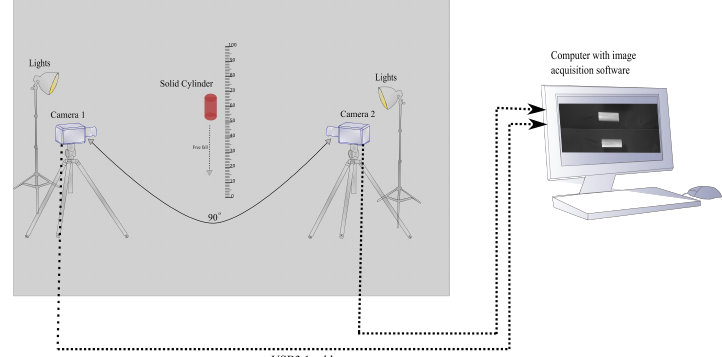
Figure 1. Measurement setup with two high-speed cameras placed 90 degrees apart and pointing to a free-falling solid cylinder. The object in red is a cylindrical object free-falling in front of the